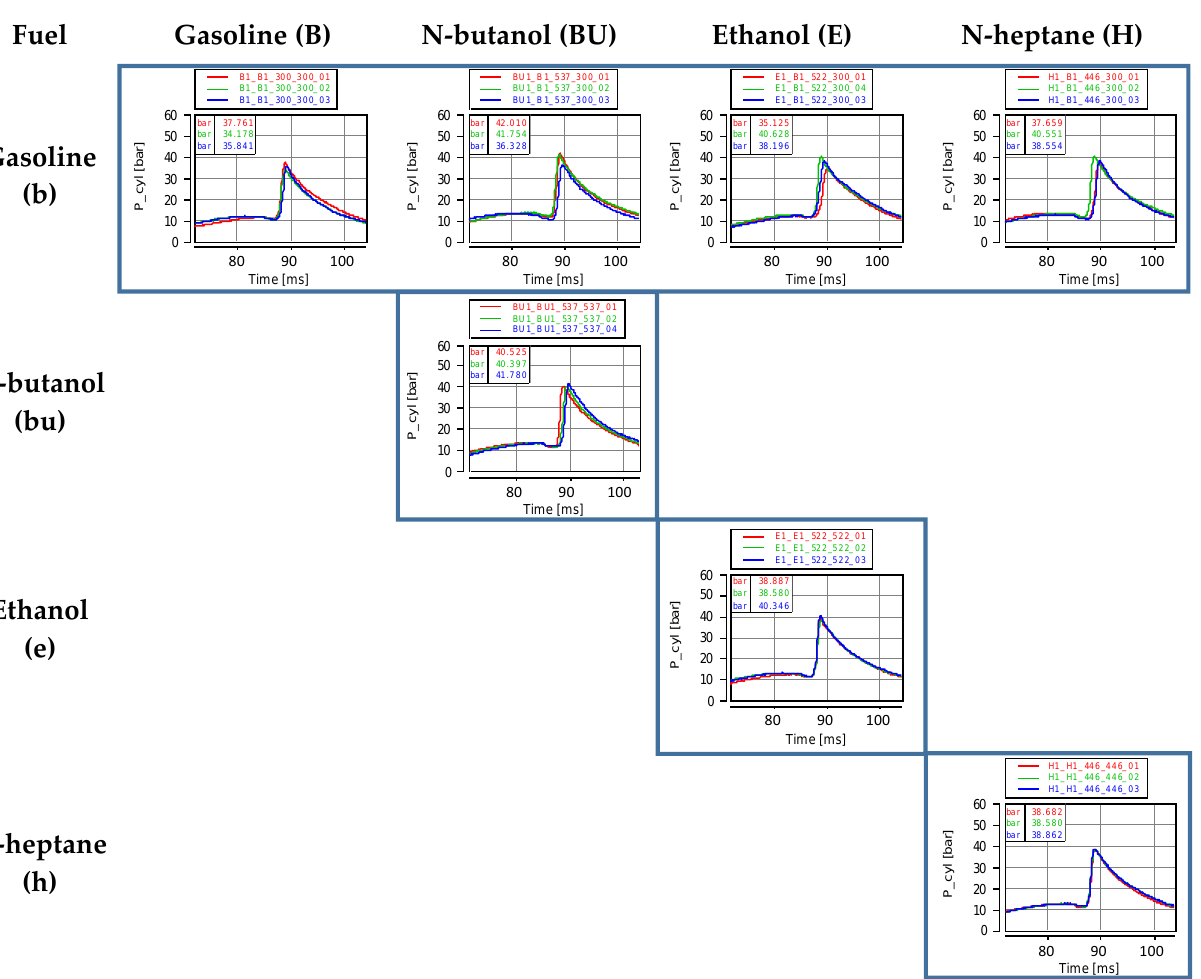
Figure 4. Summary of indicator tests (pressure in the RCM cylinder) concerning the combustion of two fuels (tests were repeated three times).